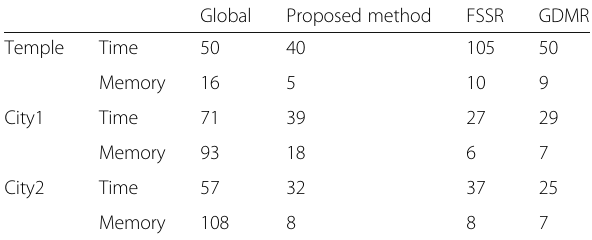
Table 3 The different methods and the time (min) and peak memory consumption (GB) for the three